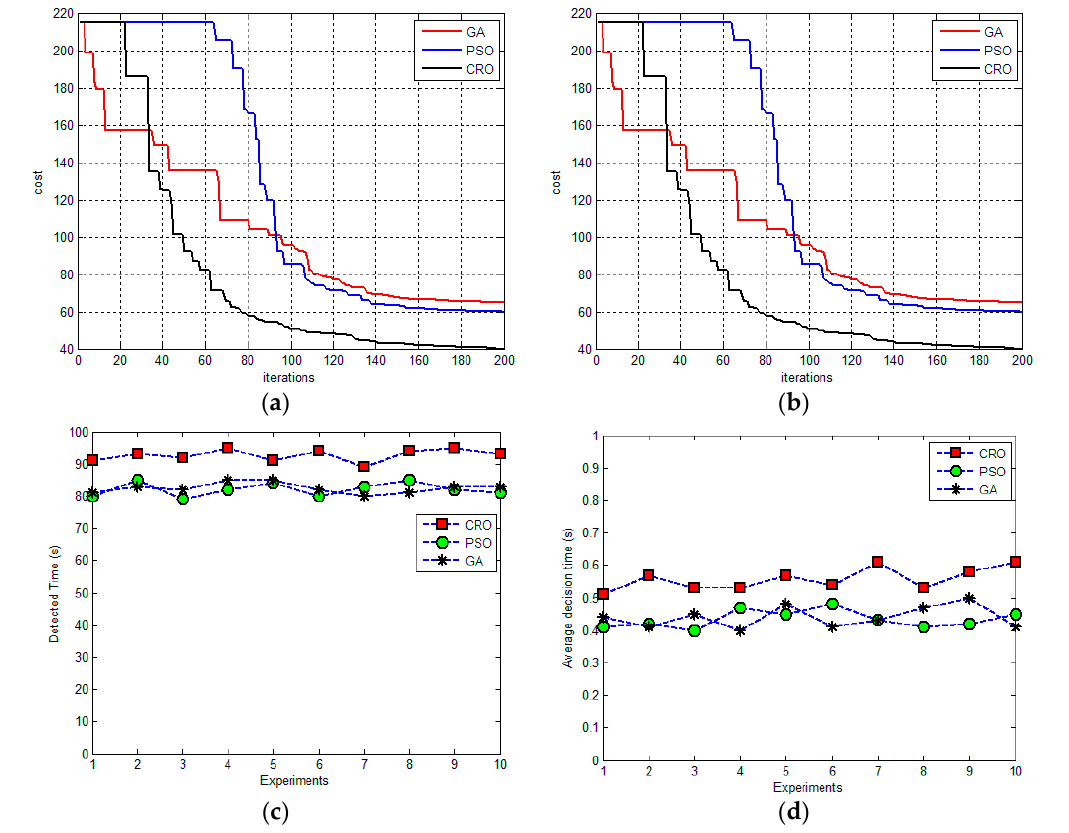
Figure 8. The performances of using different evolutionary optimizers for determination of the tracking path for scenario 1. ( a ) and ( b ) illustrate the convergence of different methods in selected decision time, respectively; ( c ) shows the visibility time of the ground time for the proposed method, PSO and GA based algorithms, respectively; ( d ) is the average execution time of the aforementioned methods.